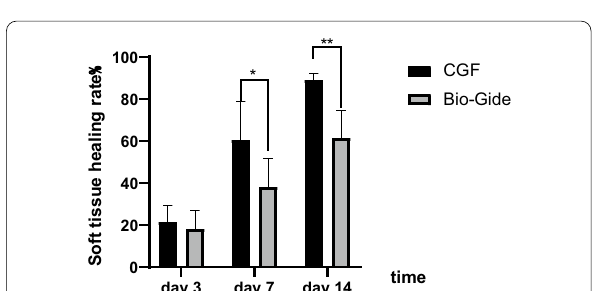
Soft tissue healing